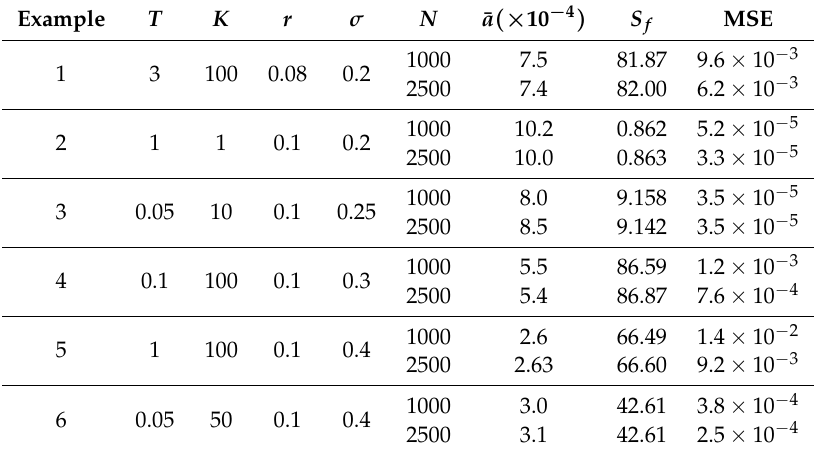
Table 1. Numerical results of the corresponding parameter